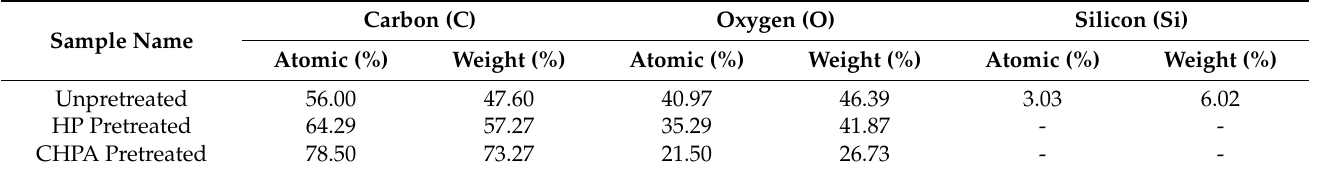
Table 5. Effect of untreated and pretreated (HP and CHPA) rice husk on element